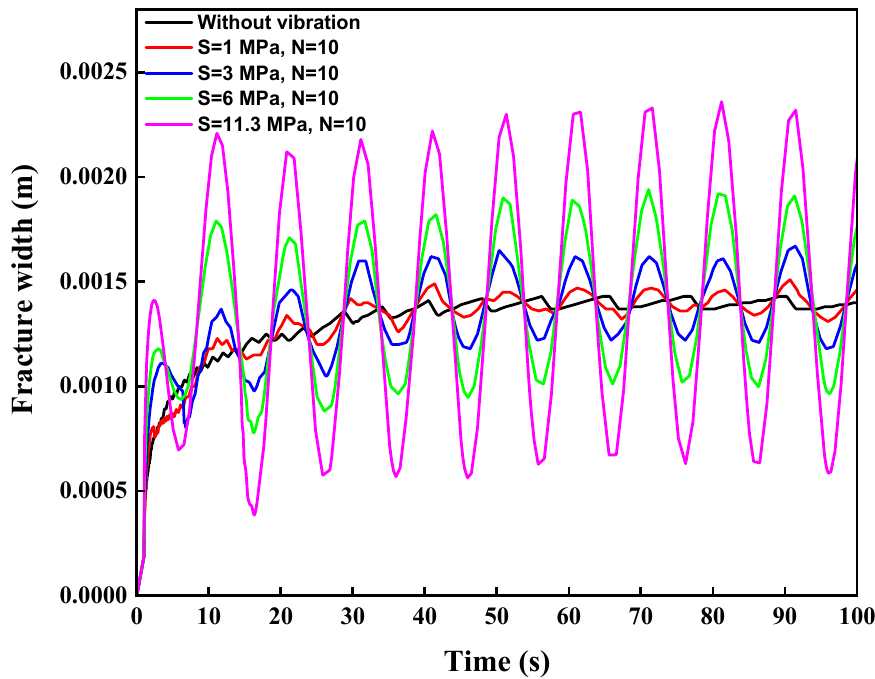
Figure 7. Fracture width evolution in function of the time for different magnitude cyclic load and constant number of cyclic loads before failure.